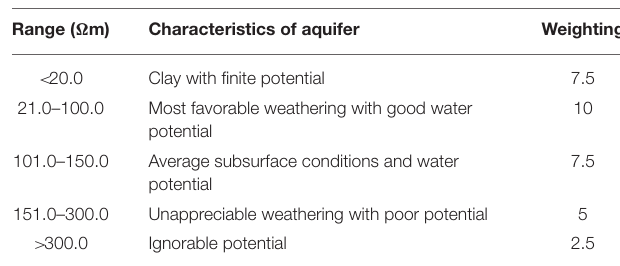
TABLE 3 | Contributions of weathered layer isoresistivity to aquifer’s potential [modified with the permission of “RMZ—Materials and Geoenvironment” after (Sunmonu et al., 2012)].